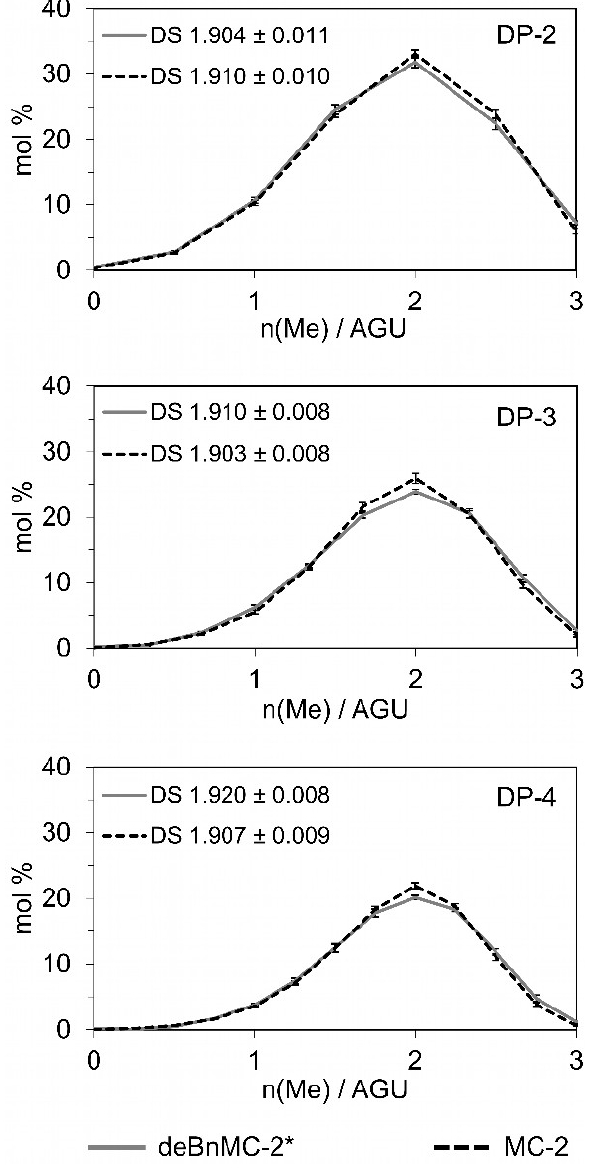
Figure 6. Evaluated methyl substitution profile and DS values of deBnMC-2* (Method-2a, Table 1) and MC-2 (for comparison) based on the oligomer analysis acquired by quantitative LC-ESI-MS of m- ABA-labeled oligosaccharides. For details refer to the Materials and Methods Section 2.7.1.